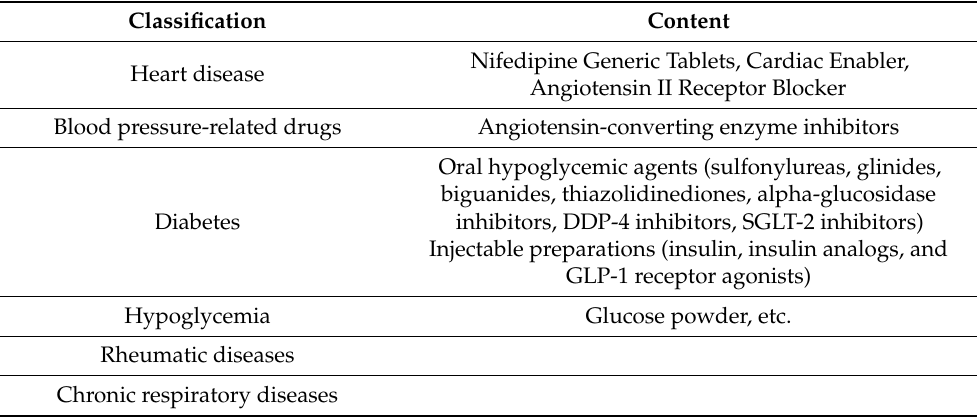
Table 5. List of supplemental stockpile drugs for families with elderly